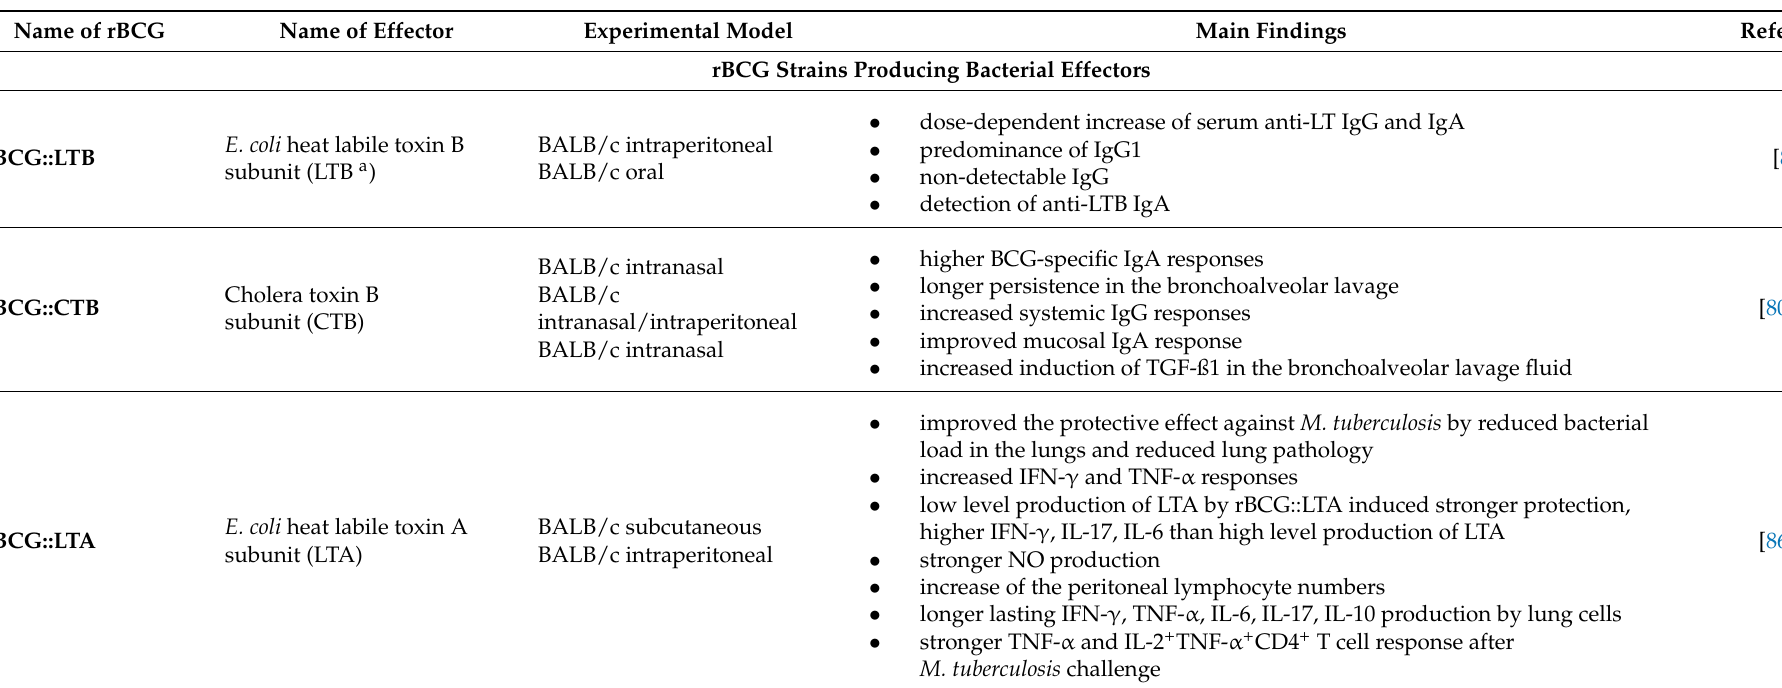
Table 2. Recombinant BCG strains producing bacterial and other non-bacterial immunomodulatory effectors. Name of